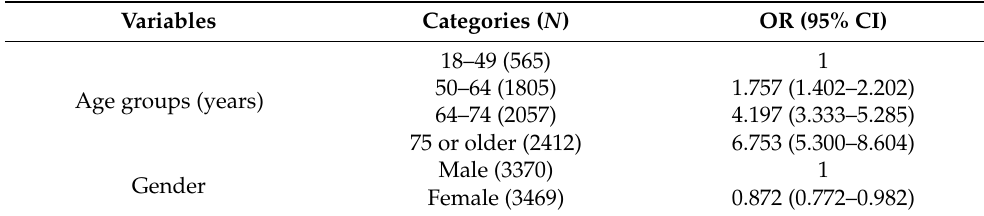
Table 3. Multivariable analysis for vaccination trends among individuals with diabetes included in SNHS 2011, EHS 2014, SNHS 2017 and EHS